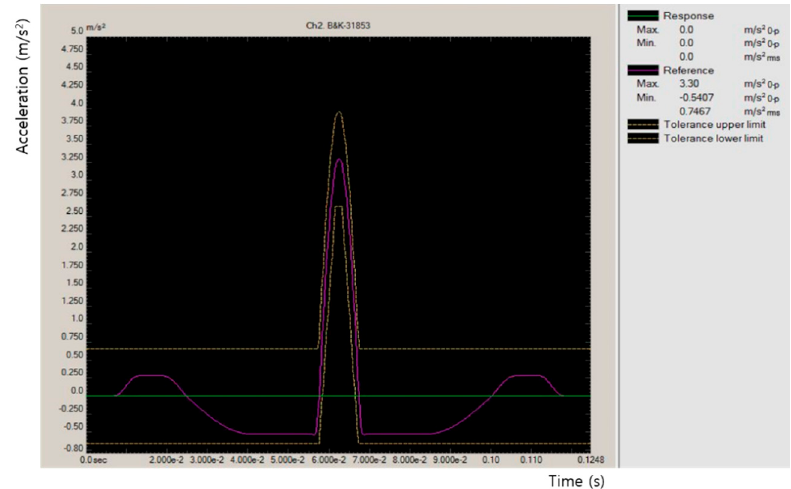
Figure 11. Acceleration data during wheelchair driving test.